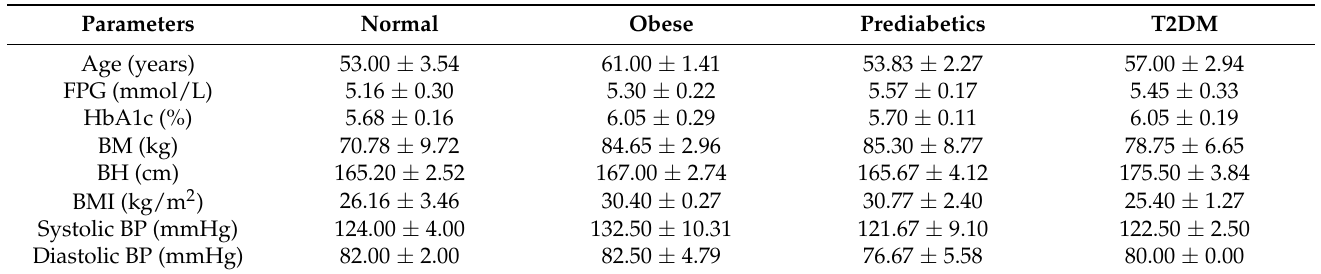
Table 1. Basic characteristics of the study